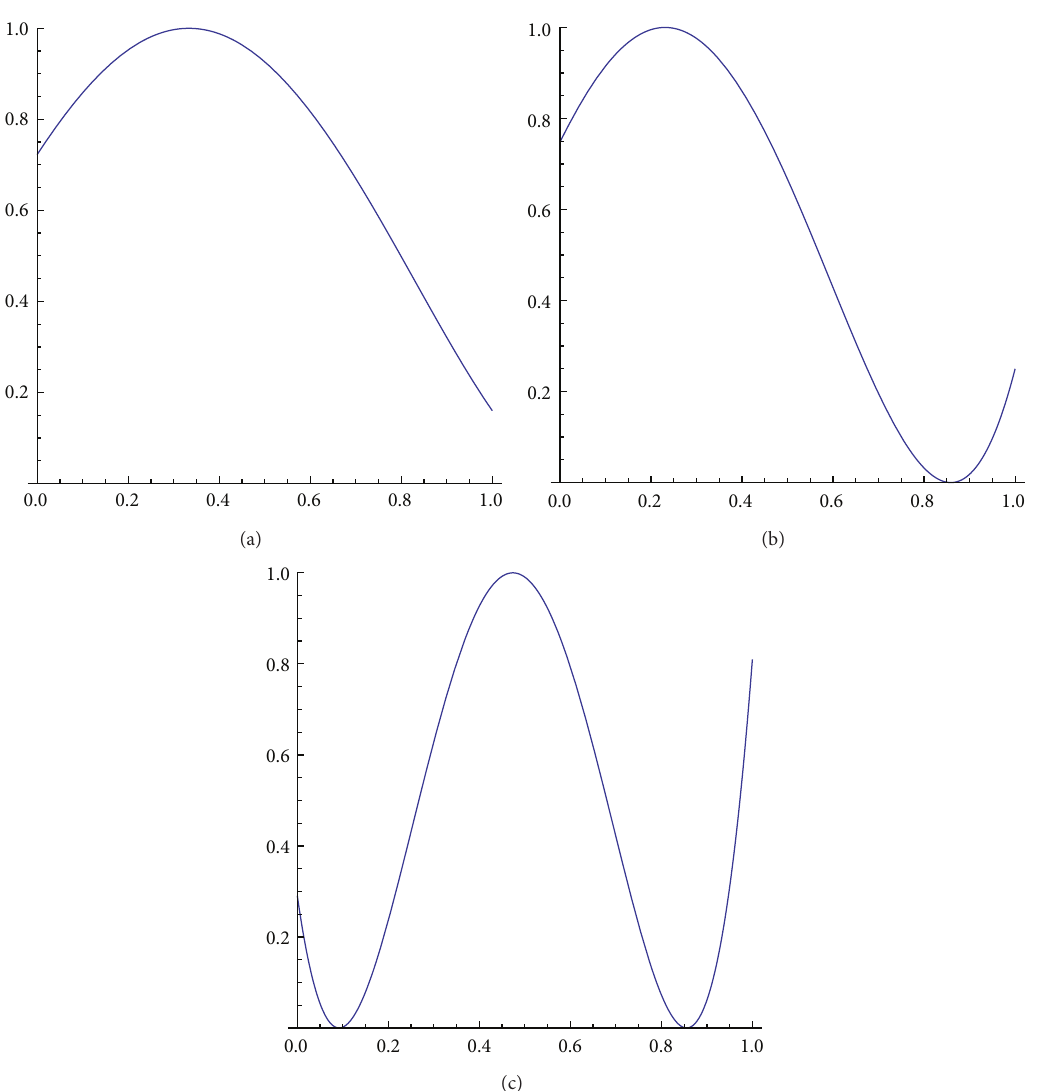
a continuous piecewise monotone function, the